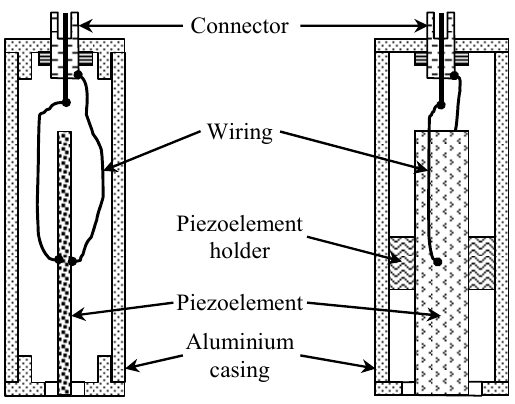
Figure 16. Cross-sections of the manufactured air-coupled transducer in two orthogonal planes.